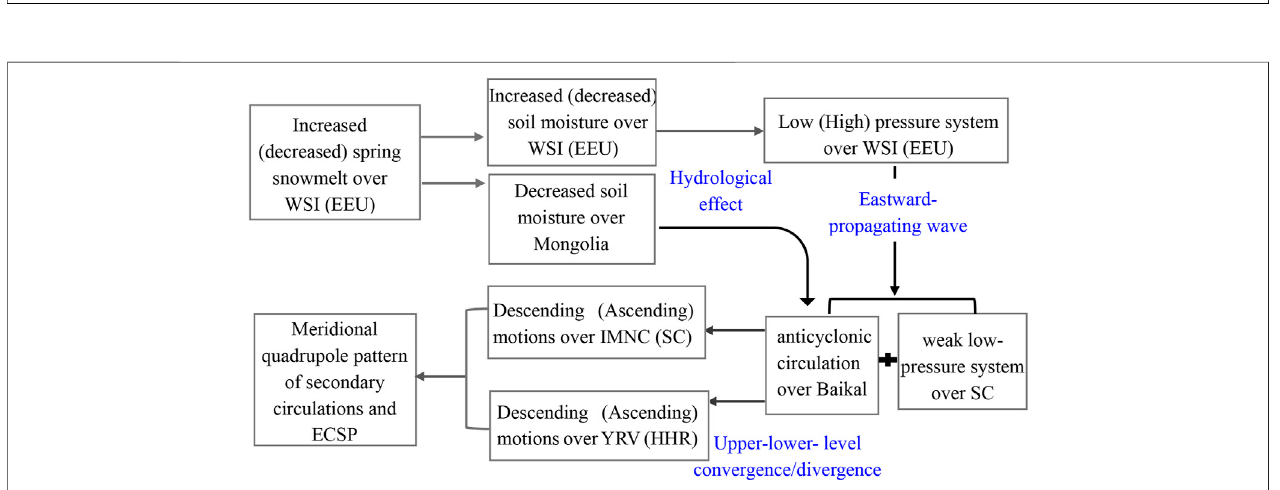
FIGURE 12 | Schematic of the process in which Eurasian spring snowmelt affects Eastern China summer precipitation.